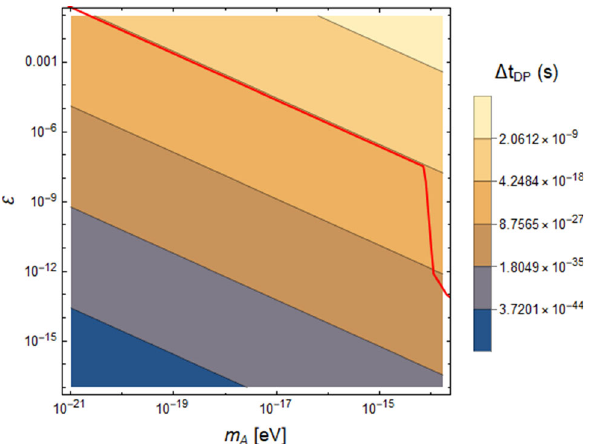
Fig. 2 Extratimedelay Δ t DP (12)duetoDPDMfortheregion m A (cid:3) ≤ ω p . We used the FRB 121102 ( z = 0 . 193),howeverallotherFRBspresentvirtuallythesamebehavior. It is shown in red the existing limits, as in Fig. 1